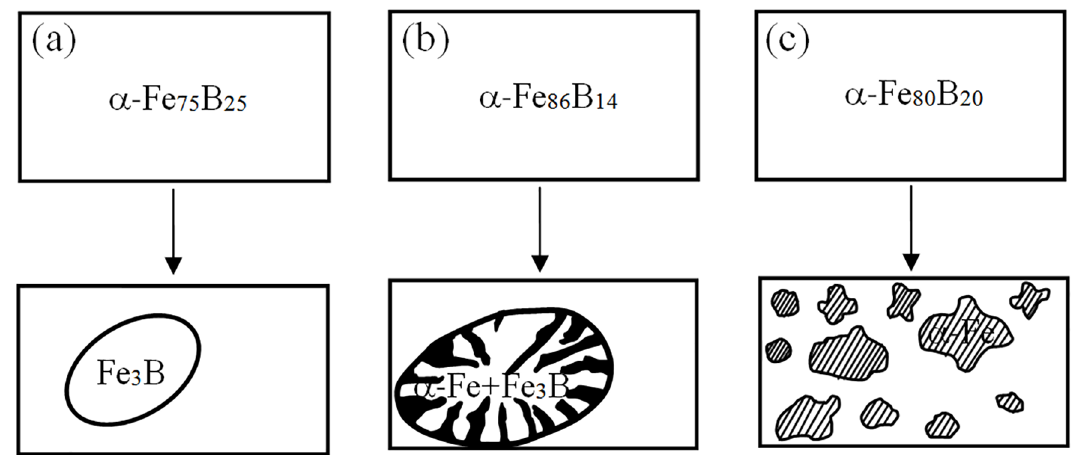
Figure 8. The schematic of the crystallization 159 : (a) polymorphous crystallization; (b) eutectic crystallization; (c) primary crystallization. phase is controlled by changing the rotation speed of wheel or the ejecting temperature of molten alloy 172,173 . Compared with the controlling of cooling rate during melt-spinning, annealing an amorphous phase with suitable composition is a more controllable method to produce an optimum volume fraction of the fcc-Al 174